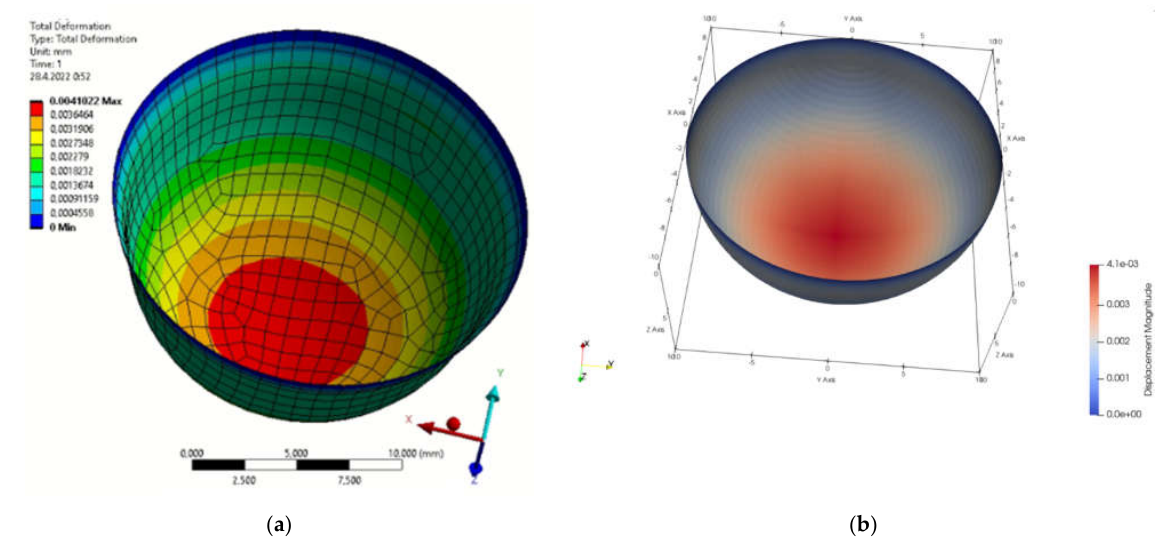
Figure 3. Total displacement field ( a ) FEM program; ( b ) MATLAB. Table 1. Computed displacements of the points for the different solution